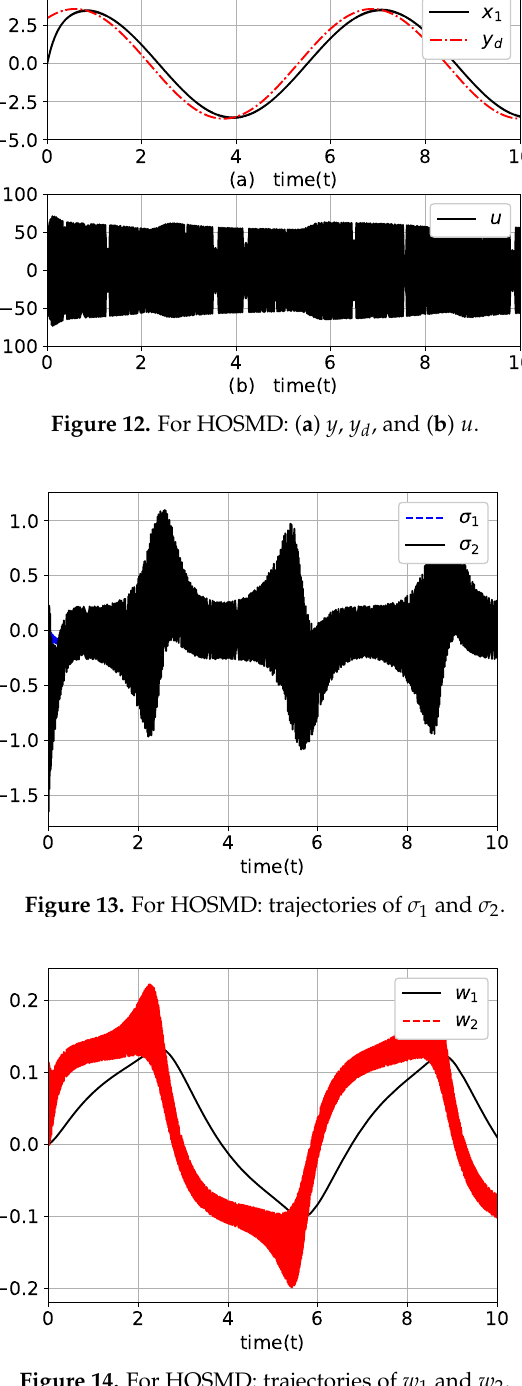
Figure 14. For HOSMD: trajectories of w 1 and w 2